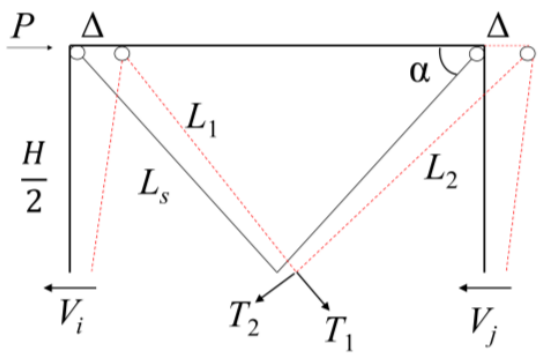
Figure 5. Structural force diagram under horizontal load.